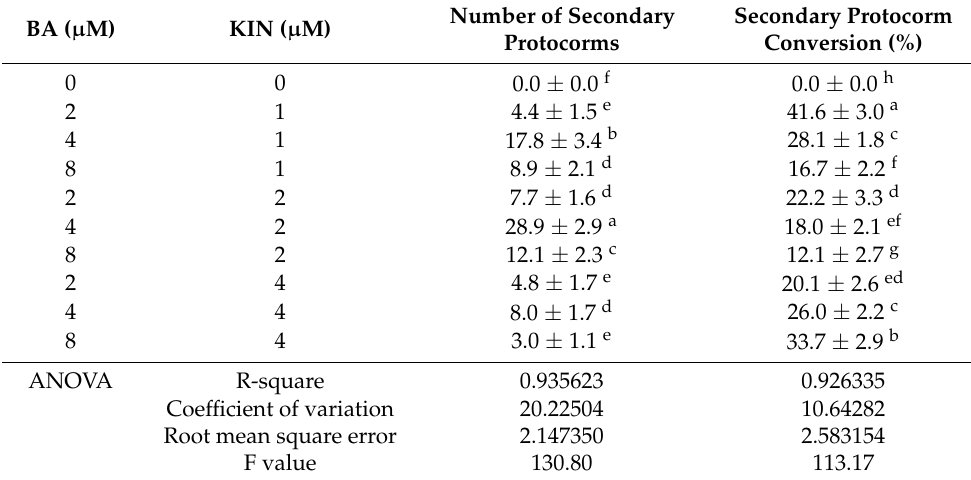
Table 5. Effects of BA and KIN on secondary protocorm formation and conversion.